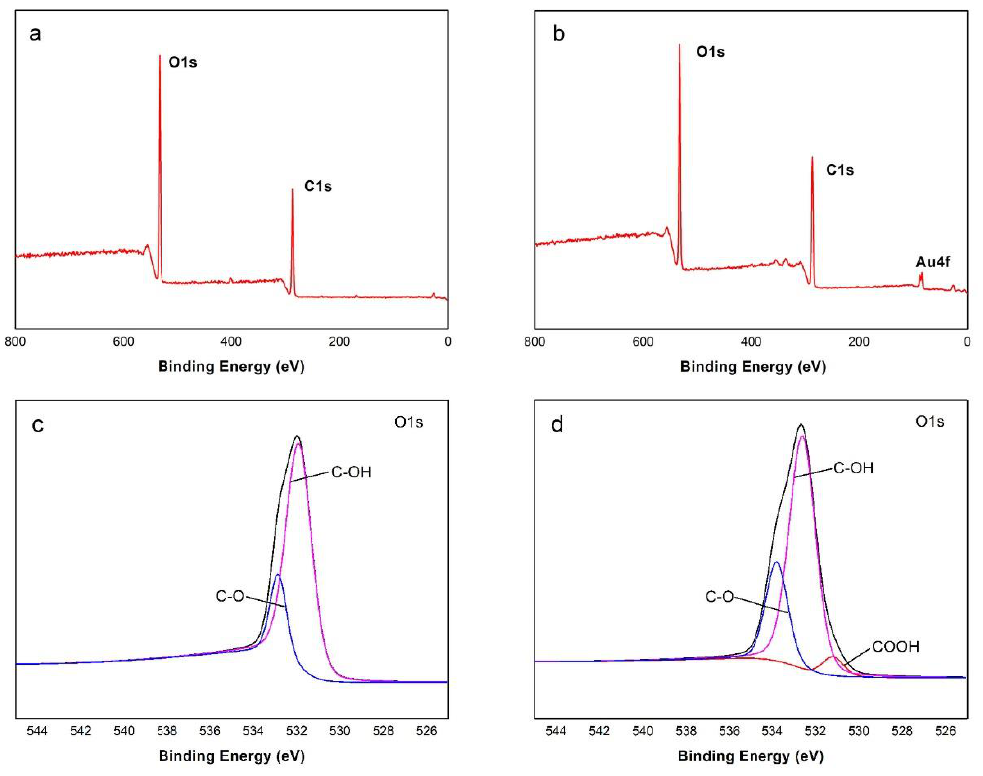
Figure 5. ( a ) and ( b ) XPS survey spectra of VCS and AuNPs@VCS. ( c ) and ( d ) High-resolution spectra of O1s of VCS and AuNPs@VCS.